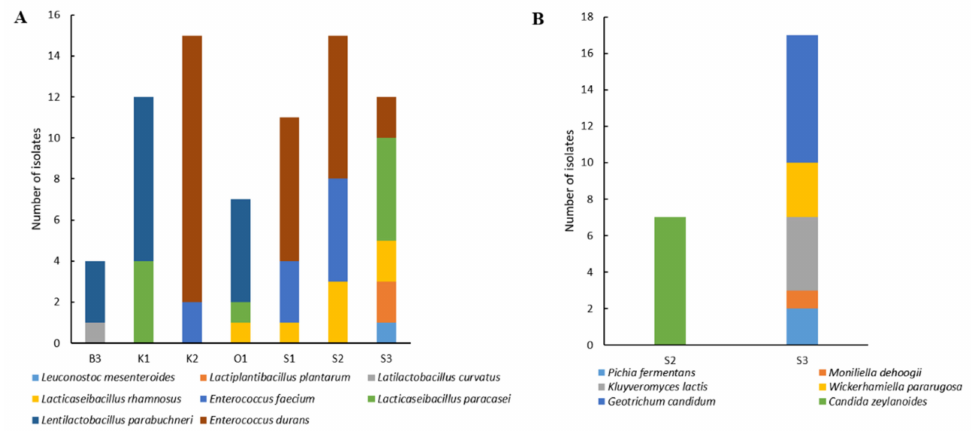
Figure 2. Bacterial ( A ) and fungal ( B ) diversity in Smen samples collected from Algerian households determined by culture-dependent